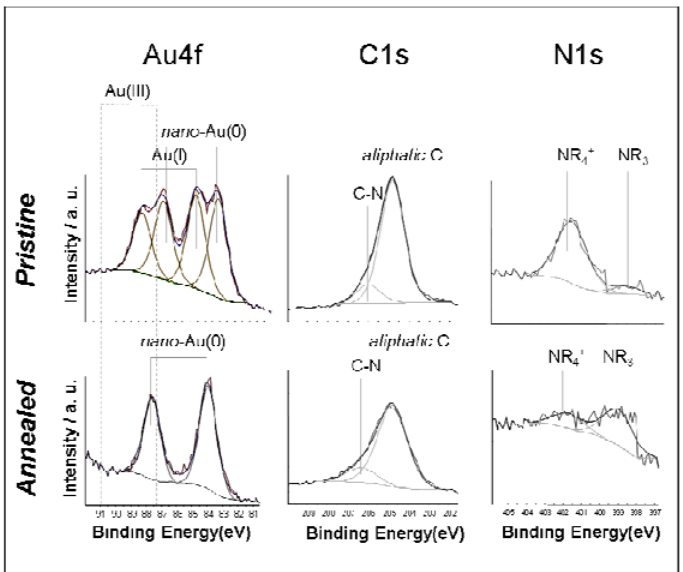
Figure 5. XP spectra and different chemical environments relevant to pristine and annealed Au-NPs. Reprinted with permission from reference